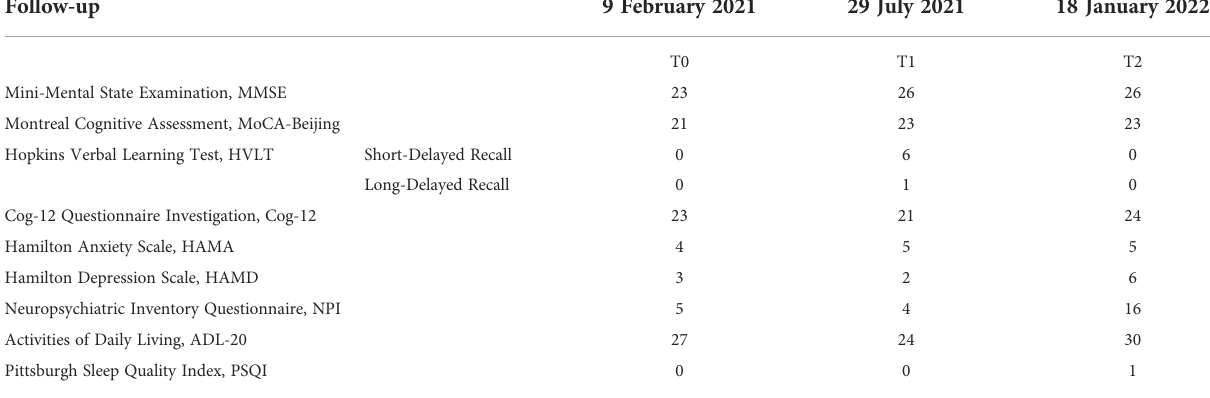
TABLE 1 Neurophysiological follow-up.